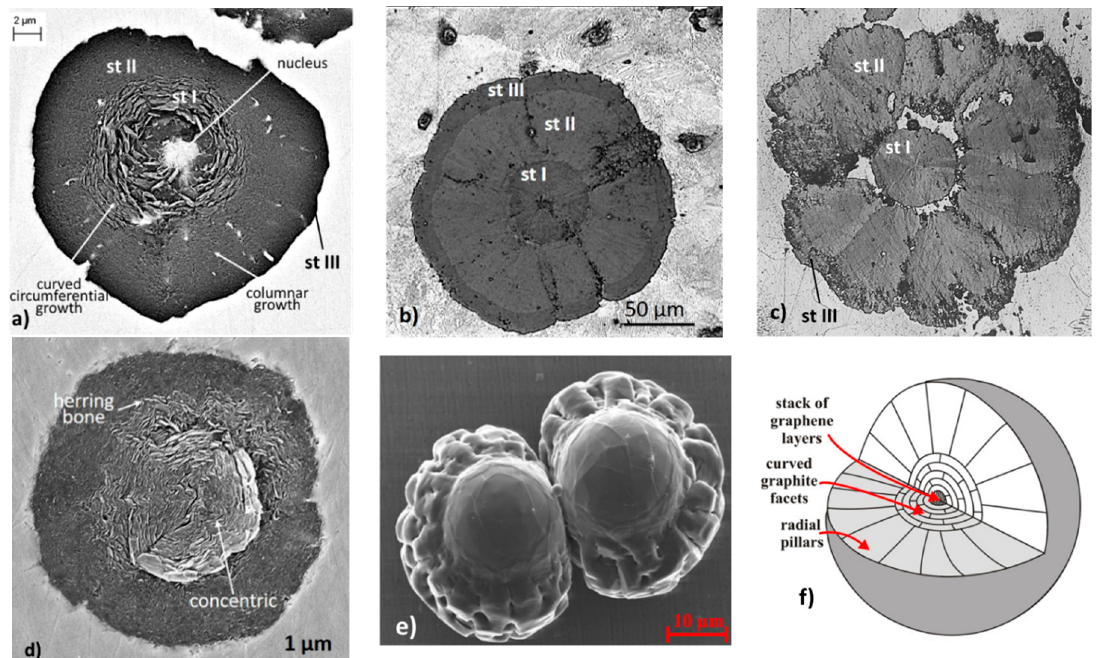
Figure 32. Multi-stage growth of graphite spheroids: ( a ) SEM image of chemically etched graphite spheroid in a Fe-C-Si 0.032% Mg alloy; ( b ) optical image of well-formed graphite spheroid (compliments of J. Barlow and A. Catalina, Caterpillar Inc.); ( c ) optical micrograph of a slightly degenerated graphite spheroid (compliments of A. Udroiu); ( d ) three-stage nodule in SG iron with 0.014% Ti, reproduced from [107] with permission from Elsevier; ( e ) graphite aggregates growing within electromagnetically levitated Ni-C melts, reproduced from [33] with permission from Elsevier; ( f ) proposed mechanism for graphite in ( e ) [33].